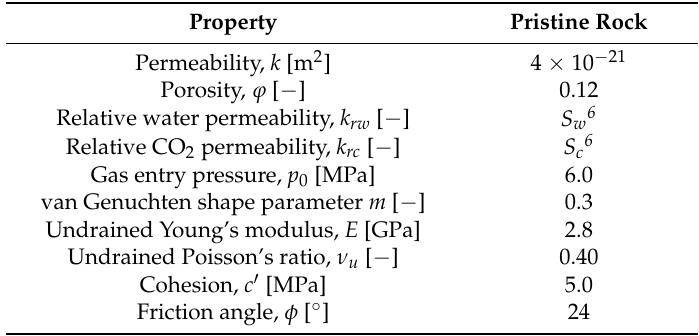
Table 1. Properties of the caprock representative–Opalinus clay (shale) [24,25].